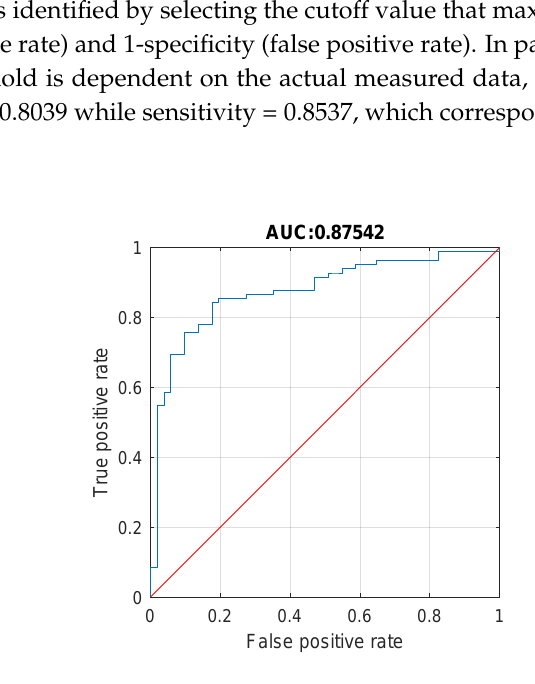
Figure 11. Receiver operating characteristic (ROC) for mean signal amplitude feature differentiating patients with cervical dystonia with and without tremor. Area under curve (AUC) is 0.87542 (95% confidence interval